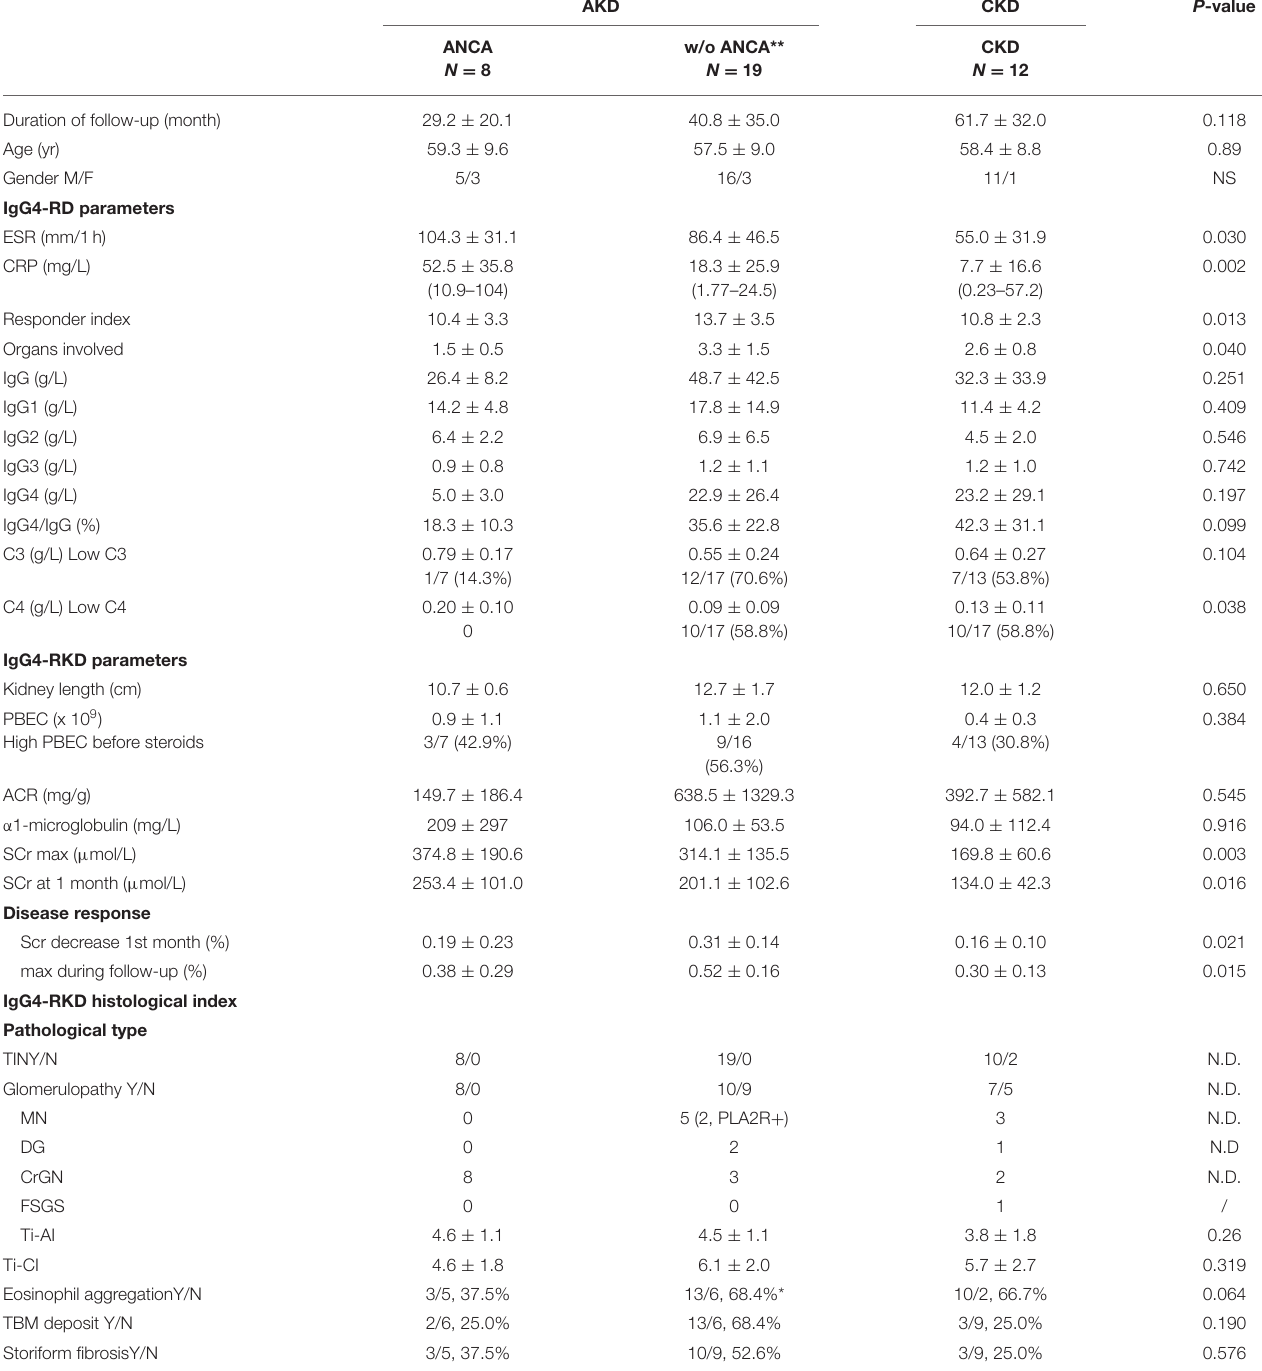
TABLE 1 | The clinical and pathological features of IgG4-related kidney disease. AKD CKD P